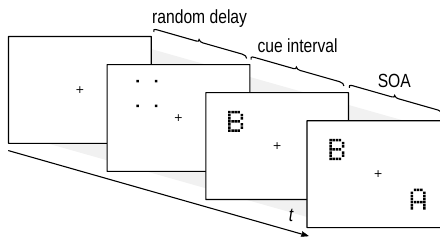
Figure 2. Exemplary display sequence of a cued temporal-order judgment trial. The SOA, the stimulus onset asynchrony, is the delay between the two targets. The trial begins with a random delay which is, in Experiment 2, followed by a cue which leads the cued target by a fixed cue interval. Stimuli are not drawn to